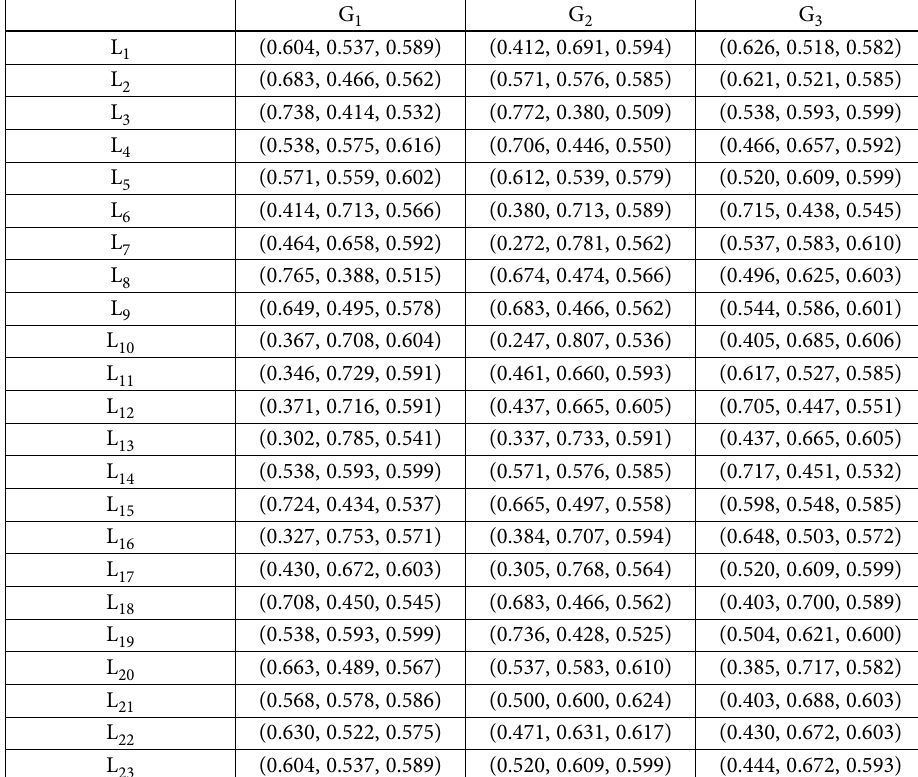
Table 6. APF-DM for alternatives over different challenges to implementing of G-IoT technologies G 1 G 2 G